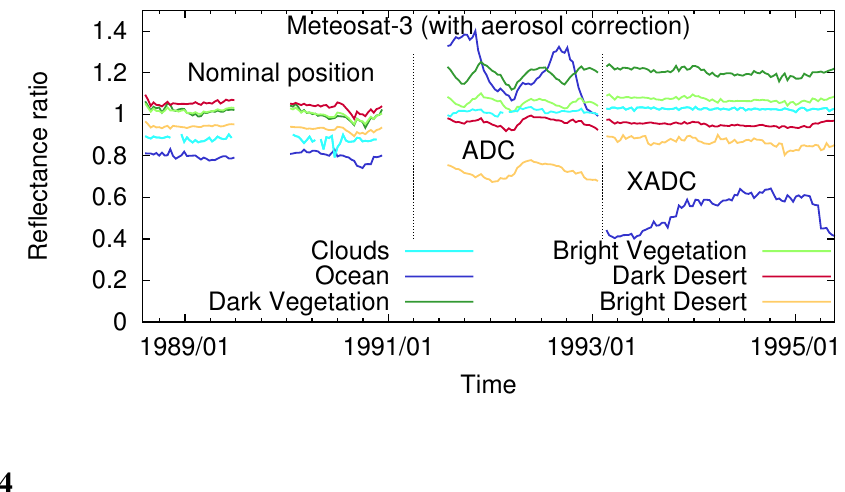
Figure 10. Original Meteosat-3 time series for the data coverage at 0 ◦ longitude